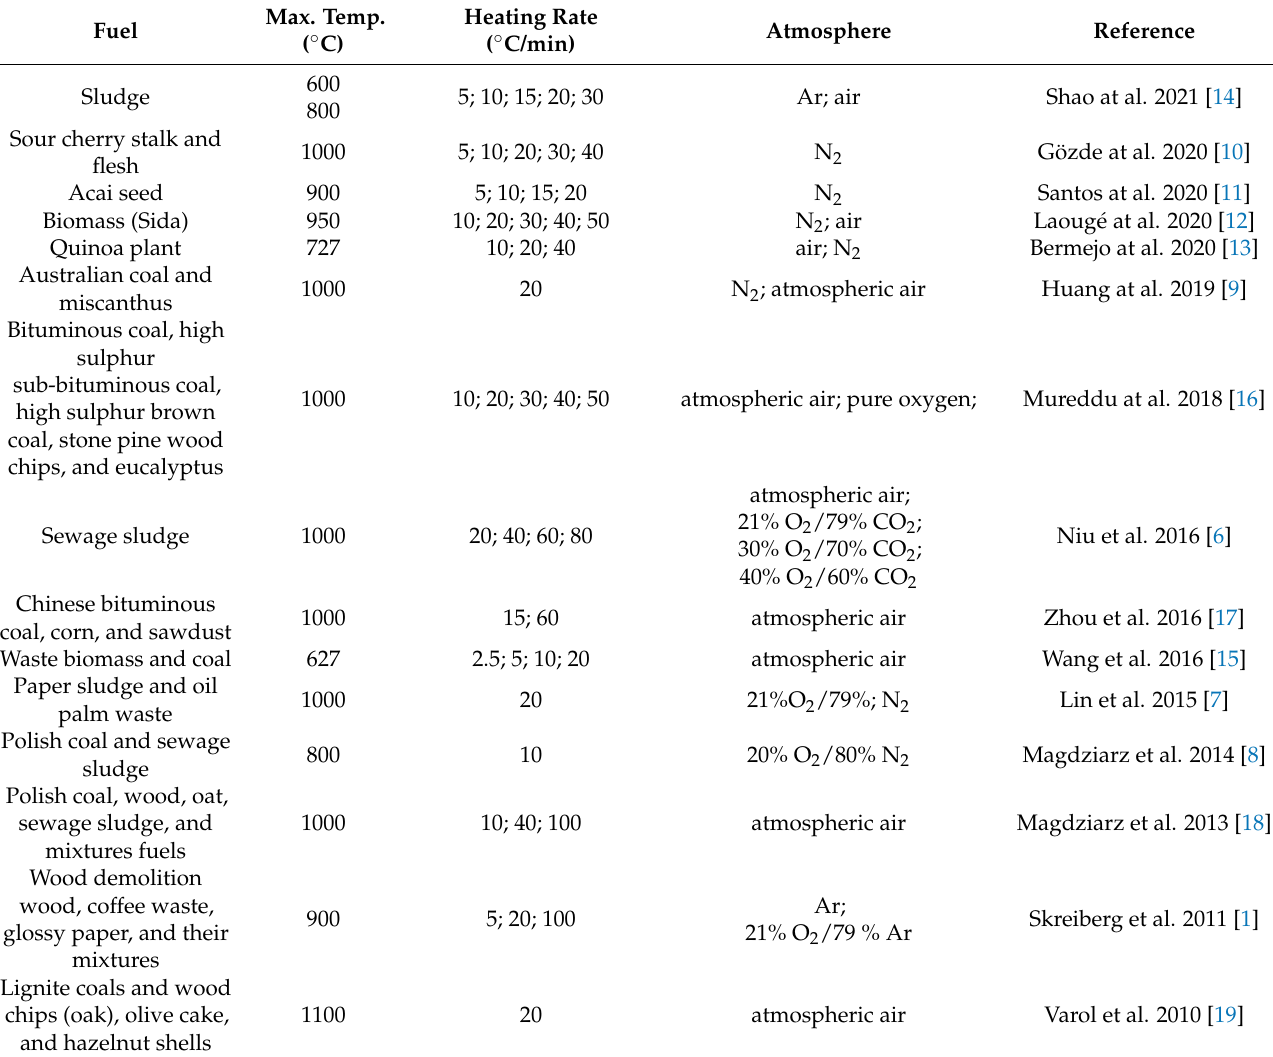
Table 1. Review of several previous studies on combustion characterization by thermogravimetric analysis (TGA) method.